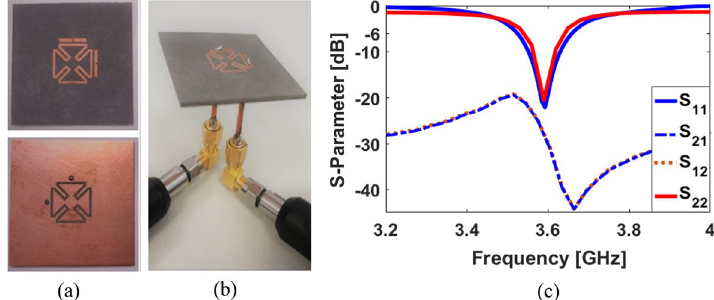
Figure 6. ( a ) Fabricated sample, ( b ) feedings, and ( c ) the measured S-parameters.